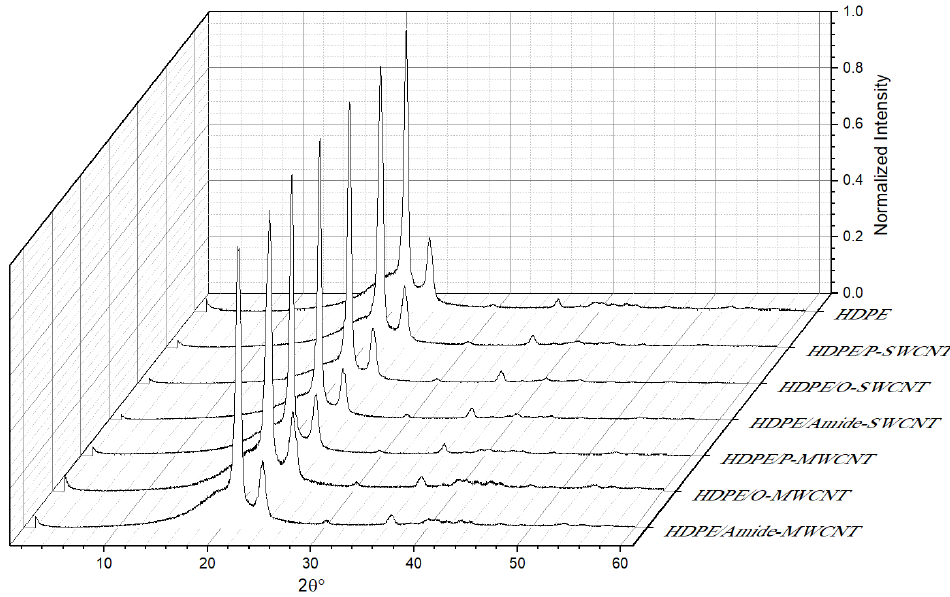
Figure 8. Normalized X-ray diffraction measurements performed on the prepared sheets M1–M7 at 2θ scanning range of 2 – 60° with a step size of 0.02°.